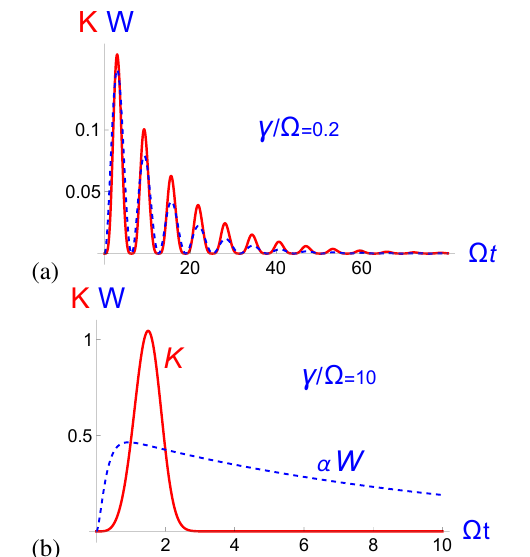
Fig. 2. Inter-emission time distribution ` ( t ) in two opposite cases, (a) for weak (b) for strong dissipative rate (with the respect to the Rabi frequency). The solid red curves pointed by the letter K are for our Kolmogorov statistical theory, equation (36). The blue dashed curves labelled W display the inter-emission time distribution deduced in [10] for same values of γ/ ⌦ which are equal to 0 . 2 in (a) and 10 in (b). In curve (b) the dashed curve displays ↵ W ( t ) ( ↵ is a numerical coe ffi cient allowing to compare the behavior of the two curves on the same